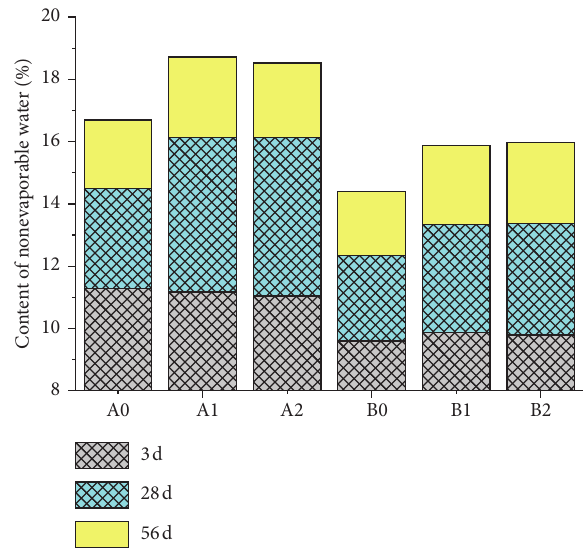
Figure 8: Effect of IC with SAP on nonevaporable water in harden cement pastes. (A) Cement pastes without FA; (B) cement pastes with